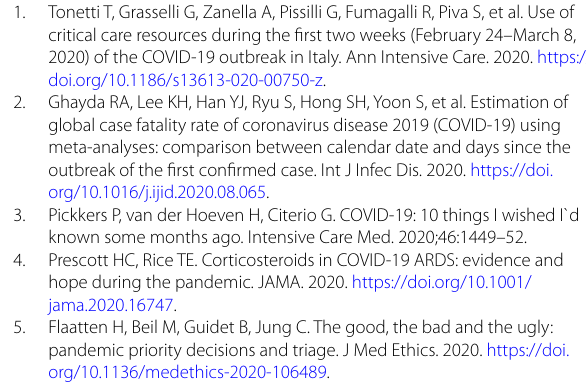
Fig. 1 Relation between ICU admission policy, quality of care and critical care organization within the